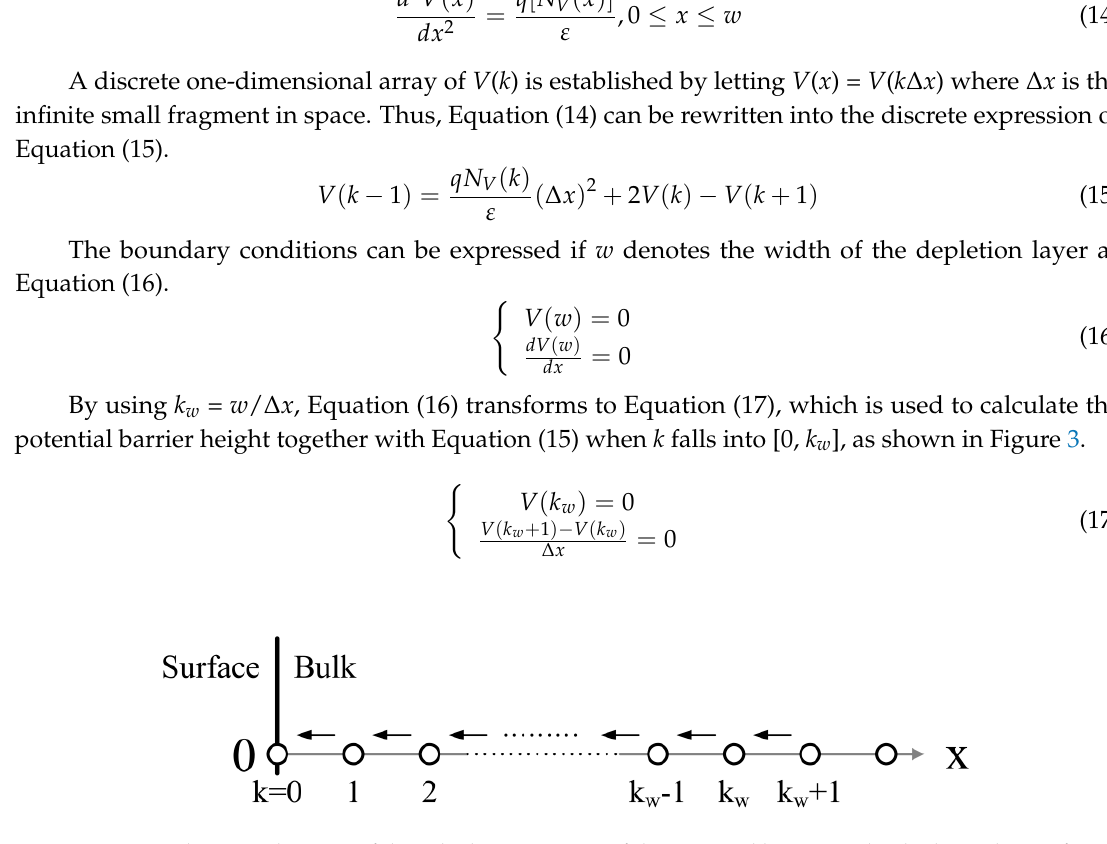
Figure 3. Schematic drawing of the calculation process of the potential barrier in the depletion layer of a semiconductor grain based on the density distribution of oxygen vacancies.